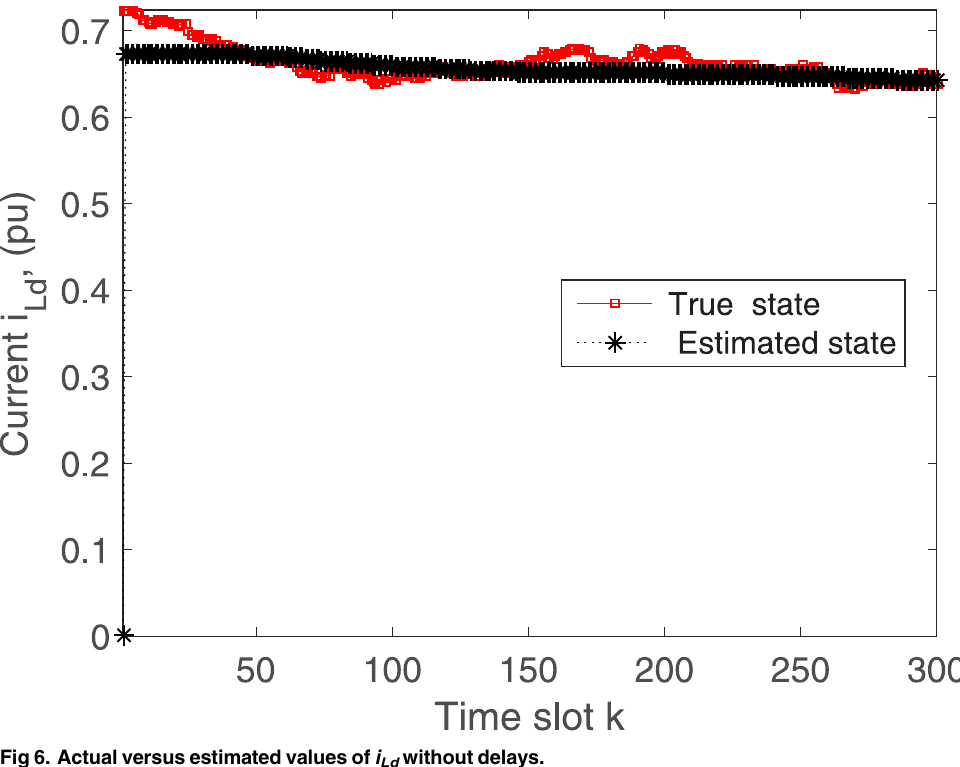
Fig 6. Actual versus estimated values of i Ld without